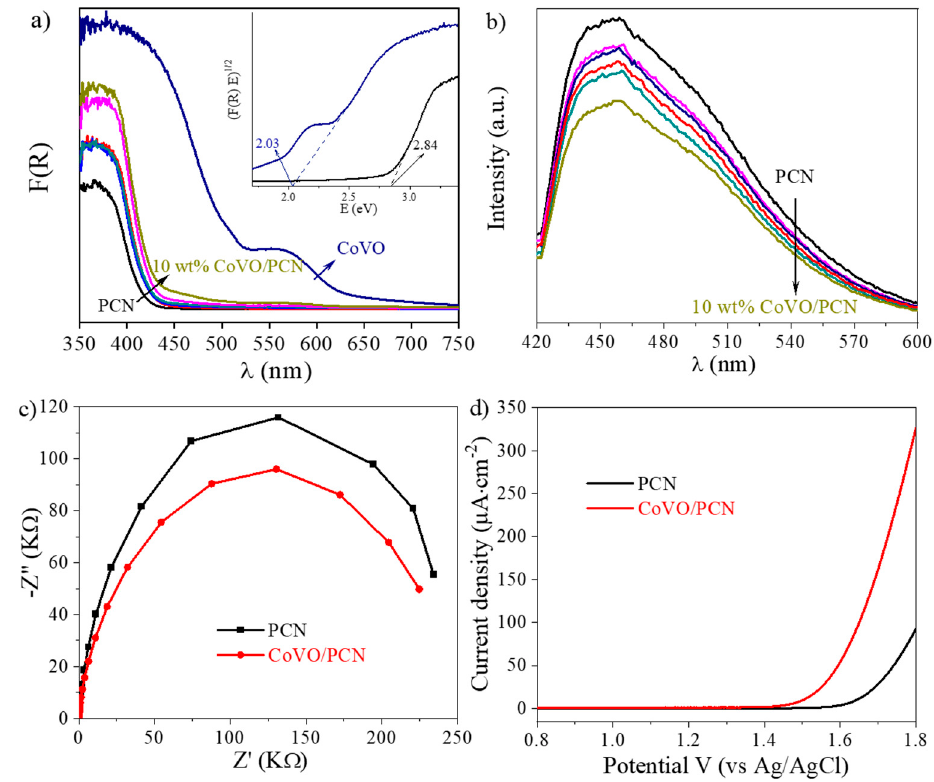
Figure 5. ( a ) UV-vis DRS spectra (inset: Taus plots); ( b ) PL spectra of x wt % CoVO/PCN samples; ( c ) EIS Nyquist curves; ( d ) Polarization curves of 3 wt % CoVO/PCN and PCN samples.